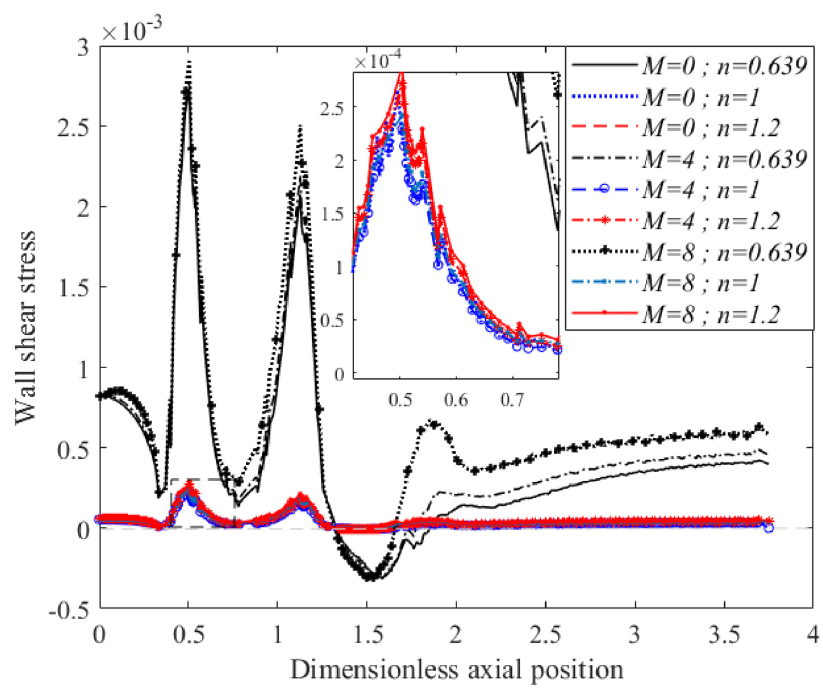
Fig 11. Wall shear stress along the outer arterial wall for different in Hartmann number and fluid characterisation (Re = 300 and τ = 0.2 a m